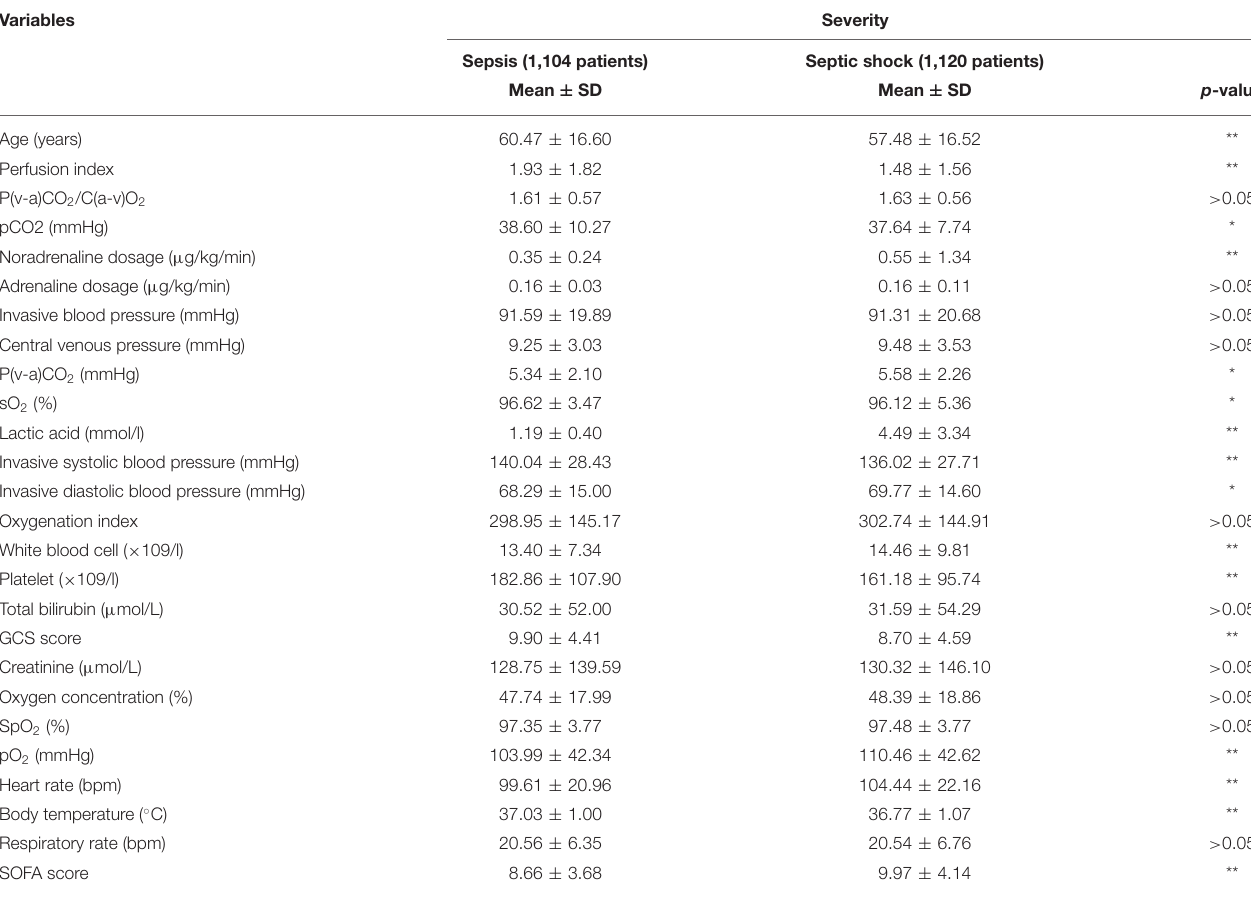
Table 1B | Subgroups of patients’ clinical data for the severity prediction.